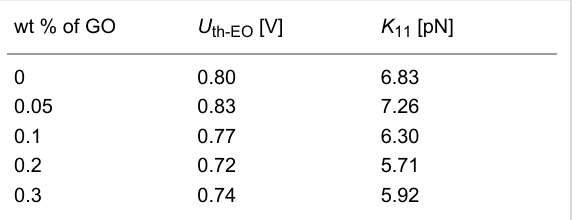
Table 2: Threshold voltage U th-EO and the calculated results of the splay elastic constants K 11 in 5CB-GO composites as a function of GO concentration.